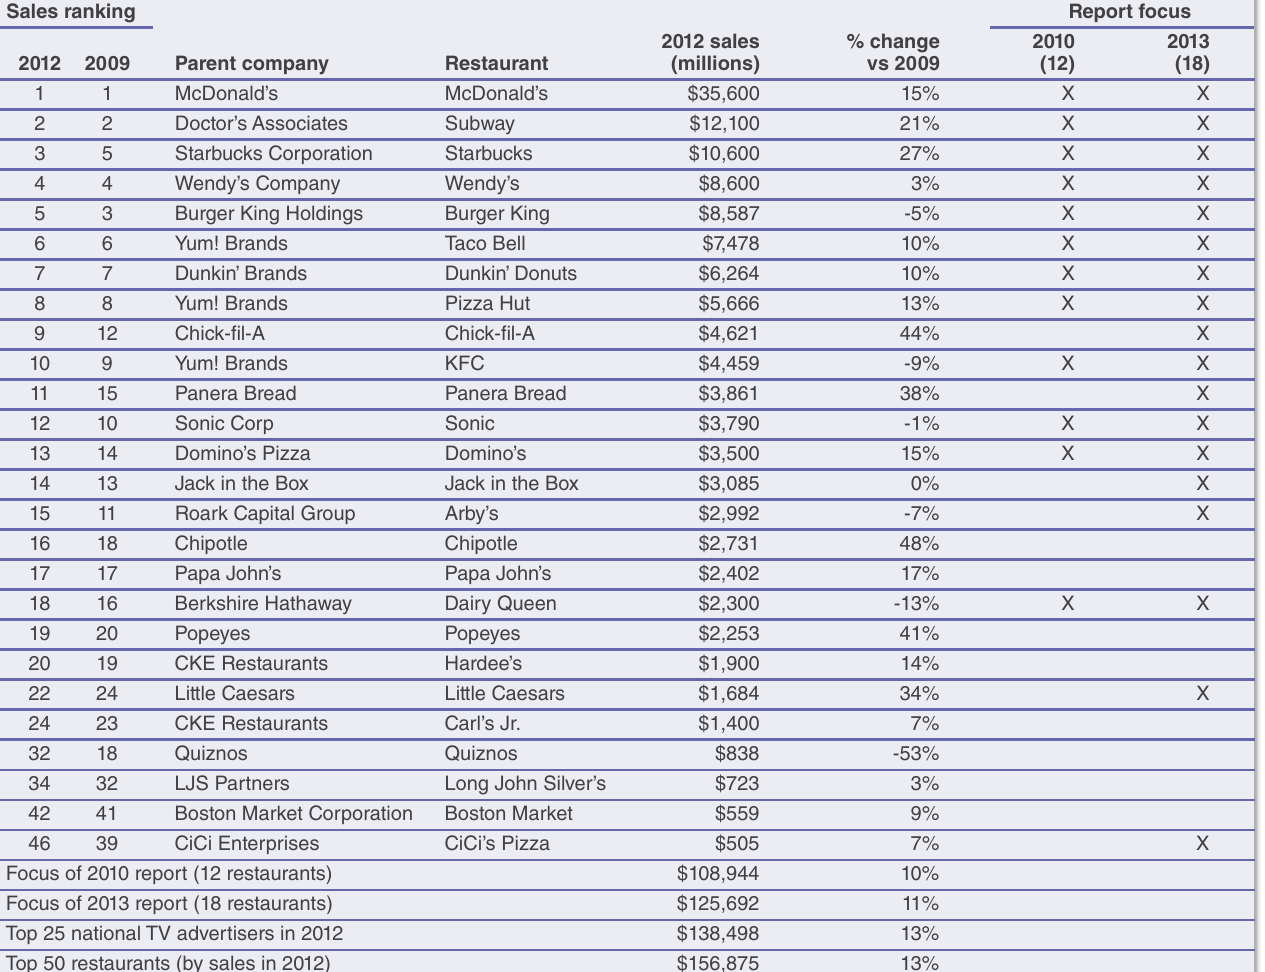
Table 3. Fast food restaurant